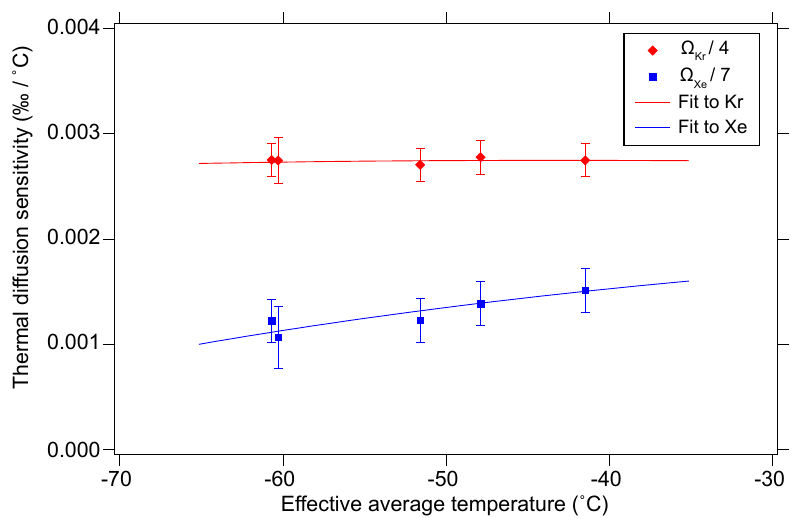
Fig. A2 Laboratory results of thermal diffusion coefficient measurements made in this study for the isotope pairs 86 Kr/ 82 Kr and 136 Xe/ 129 Xe. Values are normalized by the mass difference for ease of comparison. Curve fits shown are (cid:127) = 5 . 05 /T − 580 /T 2 and (cid:127) = 11 . 07 /T − 2000 /T 2 ‰K − 1 for Kr and Xe, respectively (curve coefficients are actual values, not normalized). Error bars represent expected error ( ± one standard deviation) based on the reproducibility of control measurements (including machine precision and gas handling error). Fluctuation of temperature during the thermal diffusion measurements contributes little ( < 1%) to the uncertainty of (cid:127) owing to the large temperature differences ( ∼ 30–40K) employed in the experiments.